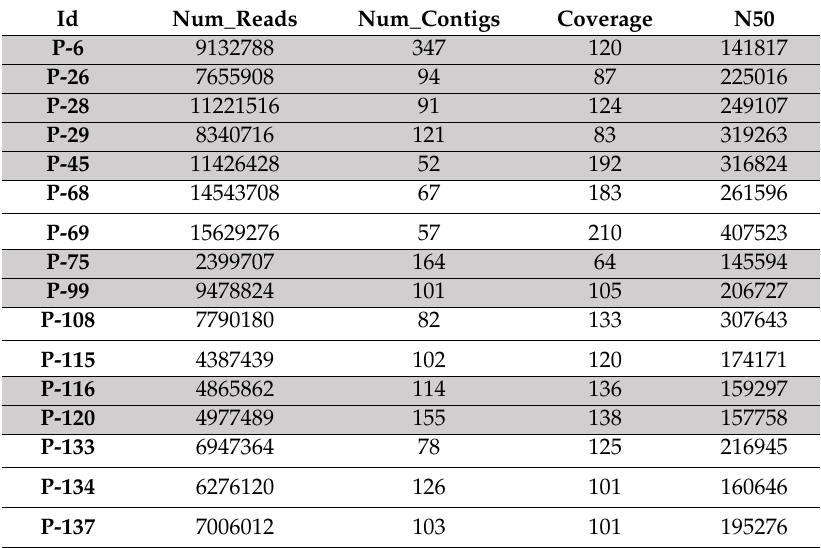
Table 4. Sequencing and assembly characteristics for the 36 isolates